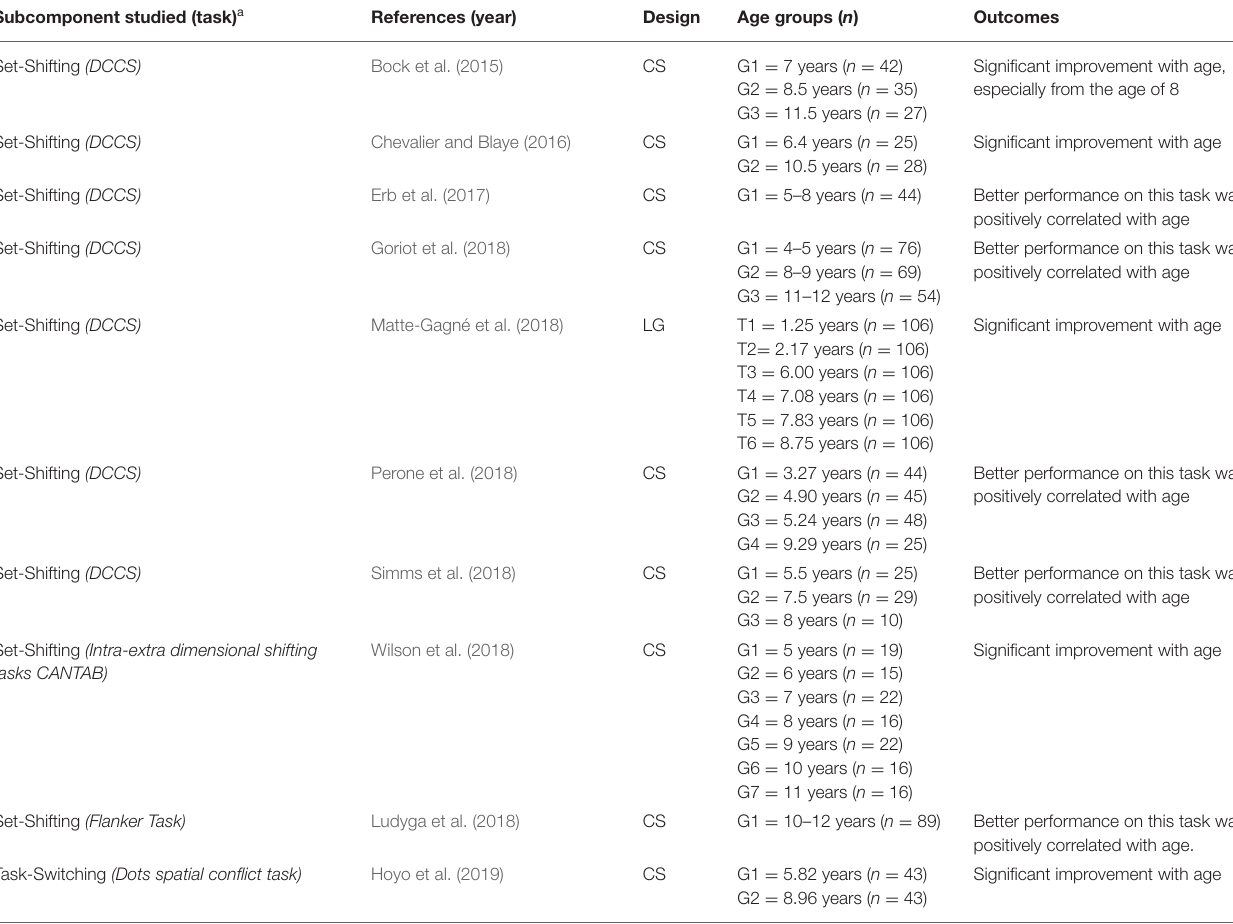
TABLE 3 | Studies on the development of the cognitive flexibility ( n =